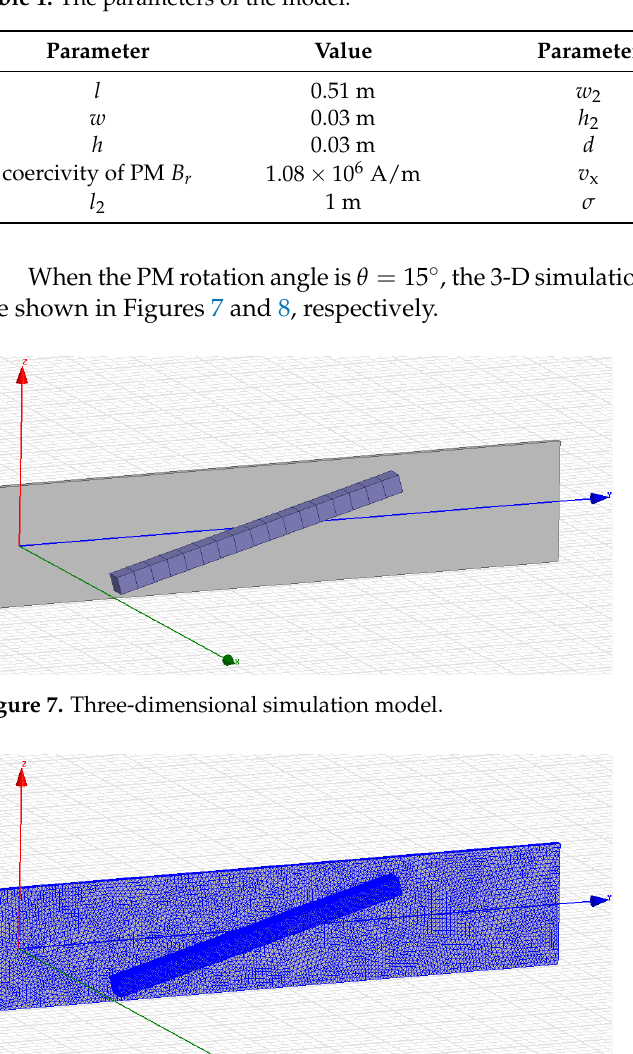
Table 1. The parameters of the model.